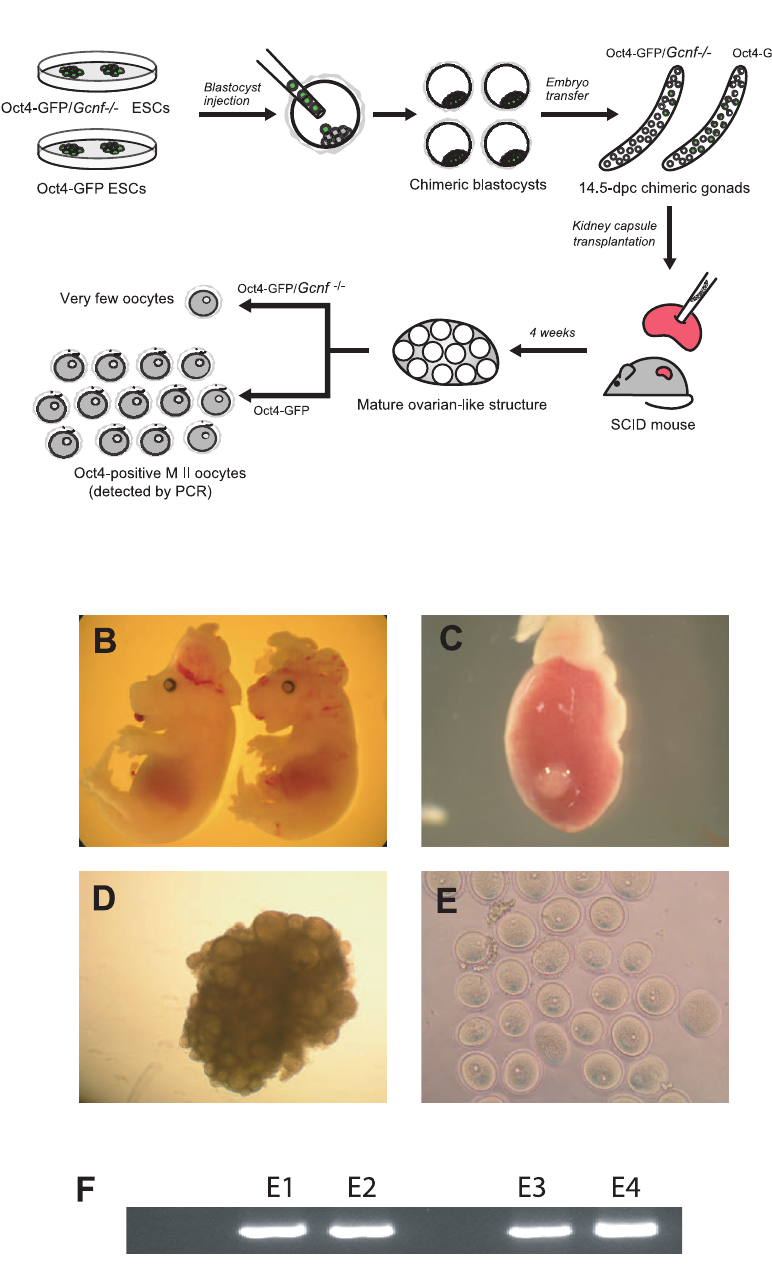
Figure 5. ( A ) Schematic overview of blastocyst injection, germline contribution, and kidney capsule transplantation of Oct4-GFP ESCs and Gcnf 2 / 2 ; Oct4-GFP( D PE) ESCs. ( B ) E14.5-chimeric Gcnf 2 / 2 embryos; note that the neural tubes and brain are affected. ( C–D ) E14.5-chimeric female gonads developed an ovarian-like structure under the kidney capsule of SCID recipients 4 weeks after transplantation. ( E ) MII oocytes isolated from only the wt ovarian-like structure and ( F ) expression of GFP performed by nested PCR from an isolated MII oocyte (E1 to E4 depicts the experimental replicate numbers). doi:10.1371/journal.pone.0103985.g005 pregnant female mice with 4-OH tamoxifen on E11.5 (a time (Figure 2T). The direct correlation between Gcnf and Stra8 point late enough not to affect the early developmental require- expression in developing gonads (Figure 2M, 2N and 2T) suggests ment for Gcnf) and then harvested embryos on E15.5 to analyze that the retinoid-induced activation of Stra8 expression during the differentiation of ESCs may reflect a role for Gcnf in the activation Stra8 expression. of Stra8 expression during gonadal development [7,29]. To test WMISH analysis of Stra8 expression in the female gonads on this hypothesis in vivo , we used the same KO model for Gcnf by E15.5 showed that Cre-negative embryos exhibited high Stra8 crossing the Gcnf fl/fl mouse with an ERT2Cre mouse. We treated expression, while Cre-positive embryos showed loss of activation of